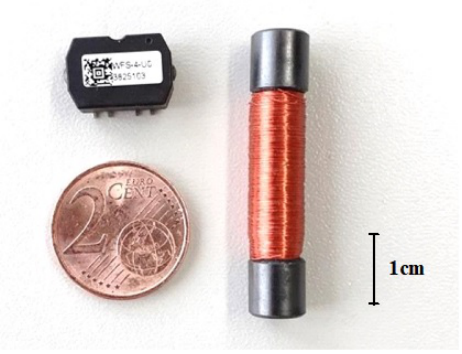
Figure 3. Digital circuit containing the UWB transceiver, MCU, oscillator and an external